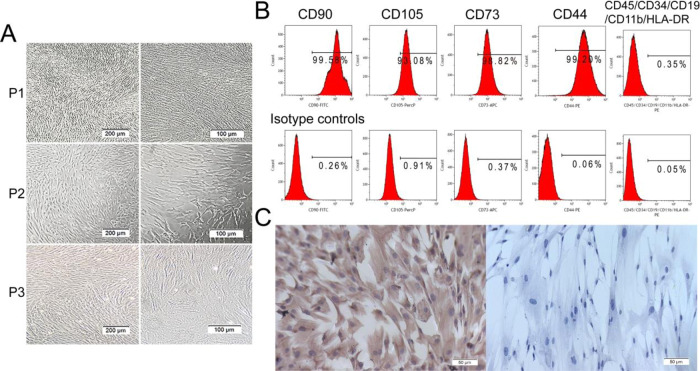
Morphology and characterization of human amniotic mesenchymal stem cells (hAMSCs). (A) morphology of passage 1−passage 3 hAMSCs. (B) Expression of hAMSCs surface markers. hAMSCs were positive for CD90, CD105, CD73, CD44 and negative for CD45, CD34, CD19, CD11b and HLA-DR. (C) Expression of vimentin of hAMSCs by immunohistochemistry.